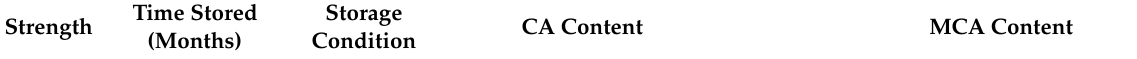
Table 4. CA and MCA content (% of labeled content) over time, stored under long-term